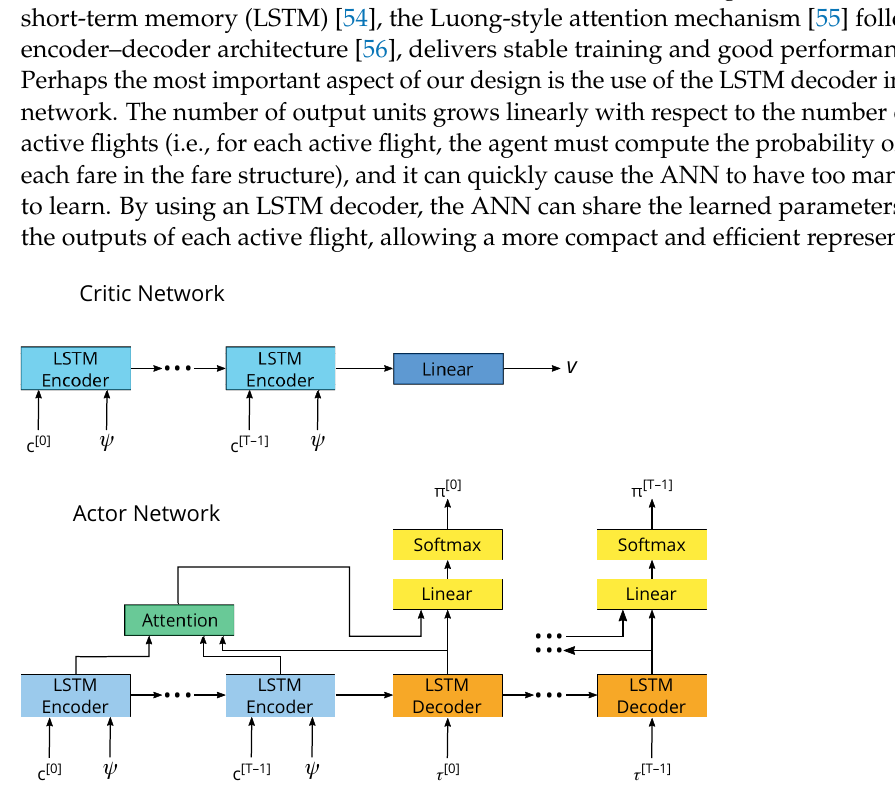
Figure 4. The artificial neural network architecture consists of two separate networks. The critic network approximates the value function, and the actor network approximates the policy function. The long short-term memory (LSTM) encoder takes the remaining capacity inputs c [ i ] , and the LSTM decoder takes the remaining time inputs τ [ i ] , and it outputs the probability of selecting each fare in the fare structure π [ i ] for each active